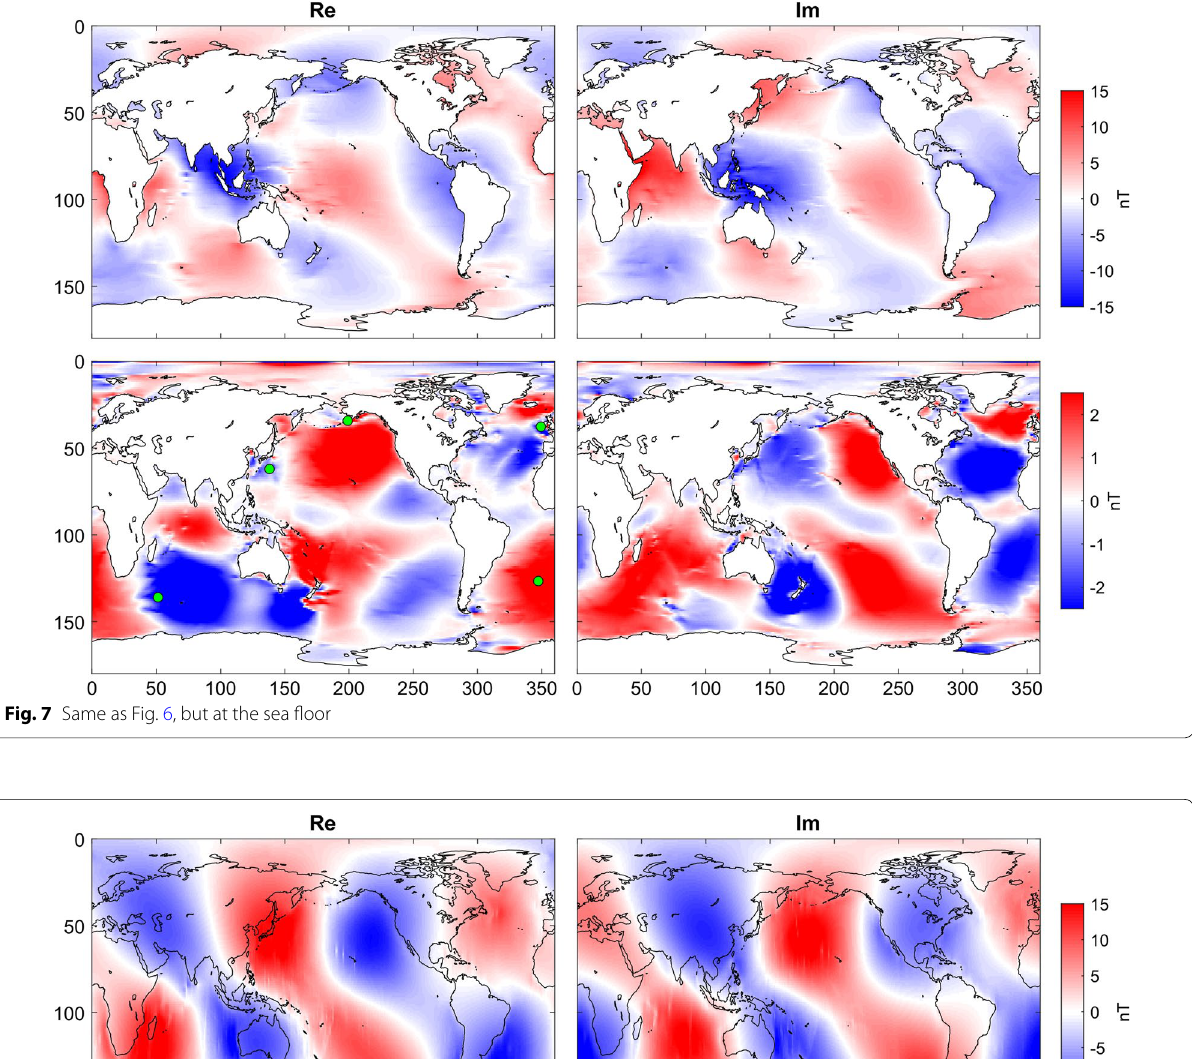
Fig. 7 Same as Fig. 6, but at the sea floor